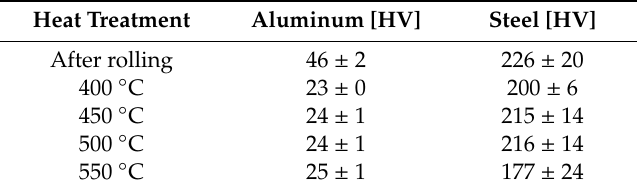
Table 2. Vickers hardness measurements of the steel and aluminum layers, after rolling and after the different heat treatments. The values are based on measurements taken in the composites subjected to both heat treatment times.